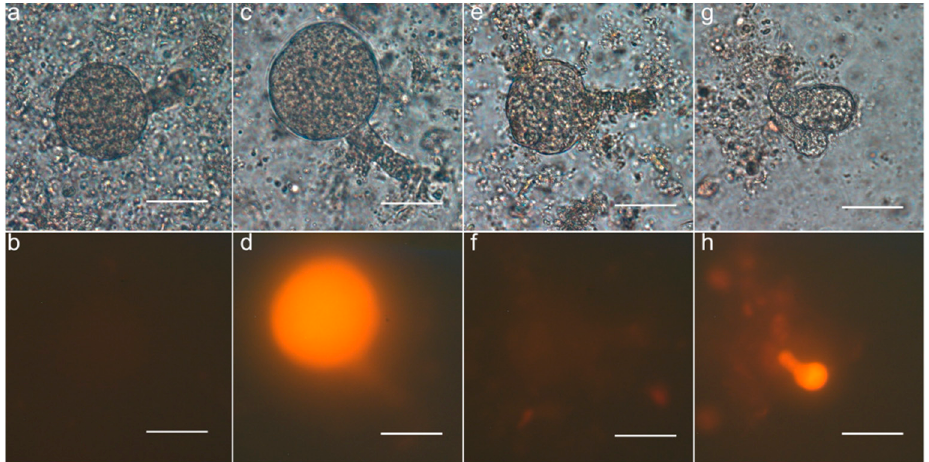
Figure 2. Expression of DsRed in developing embryos of the progeny from crosses with a homozygous transgenic tobacco line carrying a DsRed marker gene. ( a , c , e , g ) Bright field; ( b , d , f , h ) Ds-RED filter. ( a , b ) Progeny of the non-transgenic obtained by self-pollination. ( c , d ) Progeny of the non-transgenic crossed with the homozygous DsRed transgenic plant; ( e , f ) DsRed negative progeny of K6.1_12_26 crossed with the homozygous DsRed transgenic plant; ( g , h ) DsRed positive and negative progeny of